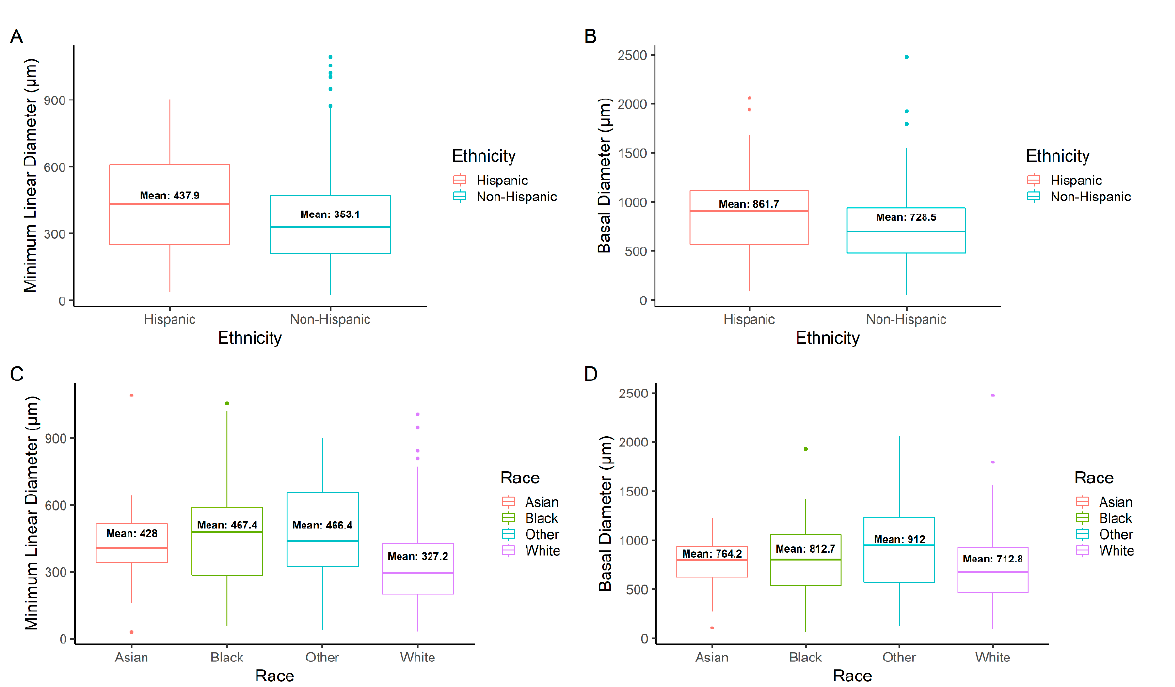
Figure 3. Minimum linear diameter (MLD) distribution by ( A ) ethnicity (Hispanic or non-Hispanic) and ( C ) race (Asian, Black, White, or Other). Basal diameter (BD) distribution by ( B ) ethnicity and ( D ) race. All MLD and BD measurements were taken preoperatively.